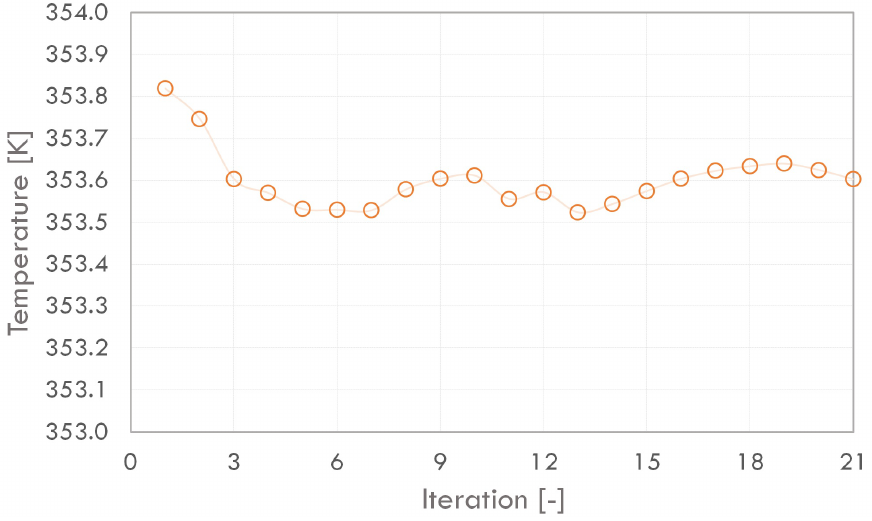
Figure 23. Change in maximum temperature of electronic